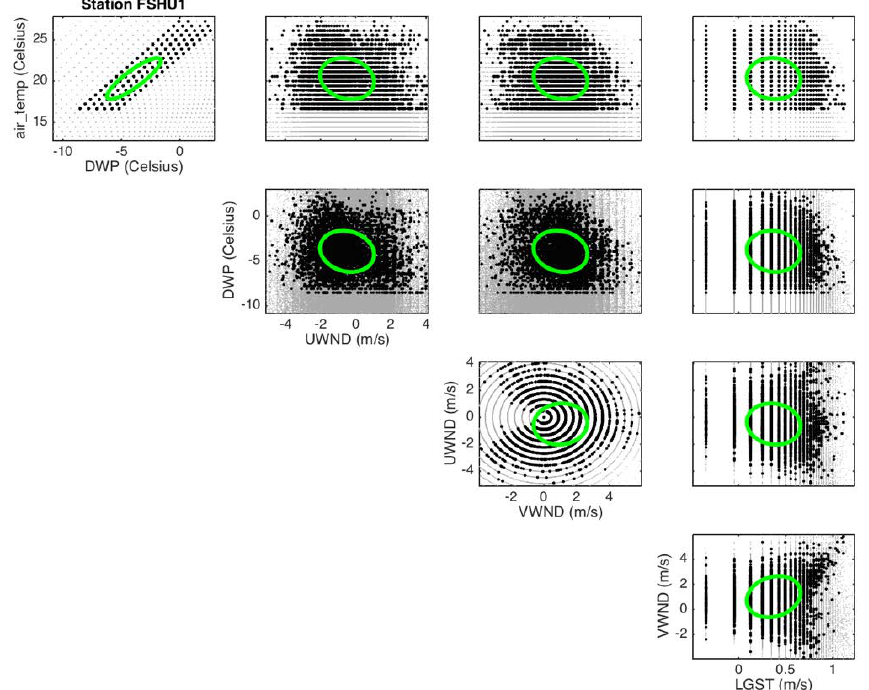
Figure 4. Scatter plots of FSHU1 pairs of state variables. Black and gray indicate values that are and are not constrained by the burn requirements. The marginal covariance of a pair of variables is depicted by the green ellipse centered at the mean and with axes equal to the deviations in the principal directions. The ellipse projections on the coordinate axes have lengths equaling twice the corresponding marginal standard deviations. Ellipse area decreases with increasing correlation (if tilting up) or decreasing anti-correlation (if tilting down); a circle would indicate zero correlation. Only the values that satisfy the minimum and maximum values for burn requirements in Table 2 are used to compute the covariances, in the considered years regardless of burn season. Table 2. Stations, time windows (mm/dd hh:mm UTC) and value limits for potential